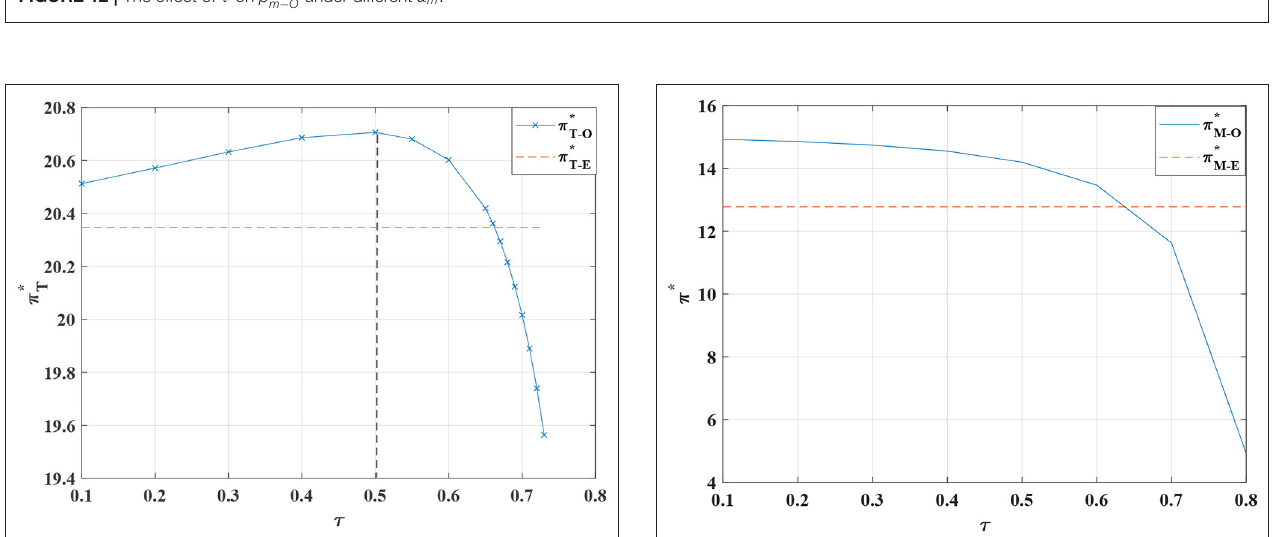
FIGURE 12 | The effect of τ on p ∗ m − O under different α m .